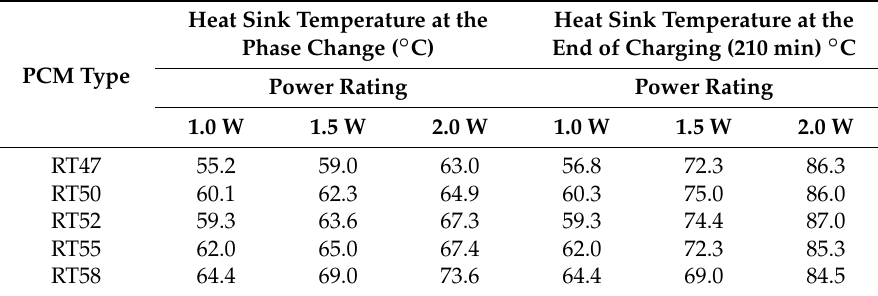
Table 1. Heat sink temperature during heat charging.